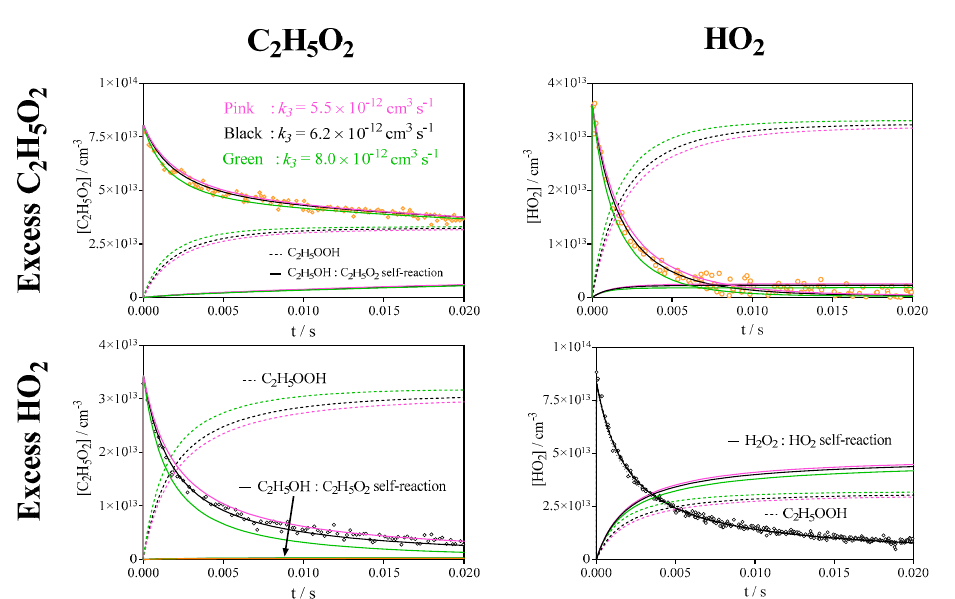
Figure 5. Experimental profiles taken under excess C 2 H 5 O 2 conditions (upper graphs) and under excess HO 2 conditions (lower graph). The dashed lines represent modelled profiles of C 2 H 5 OOH, the product from (R3), while the full lines represent the product of the corresponding self-reaction (C 2 H 5 OH for C 2 H 5 O 2 and H 2 O 2 for HO 2 ). Different colours represent the result from a model with different k 3 .